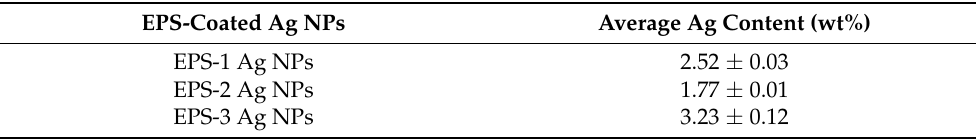
Table 3. Silver content of EPS-coated Ag NPs after filtration by 0.45 µ m